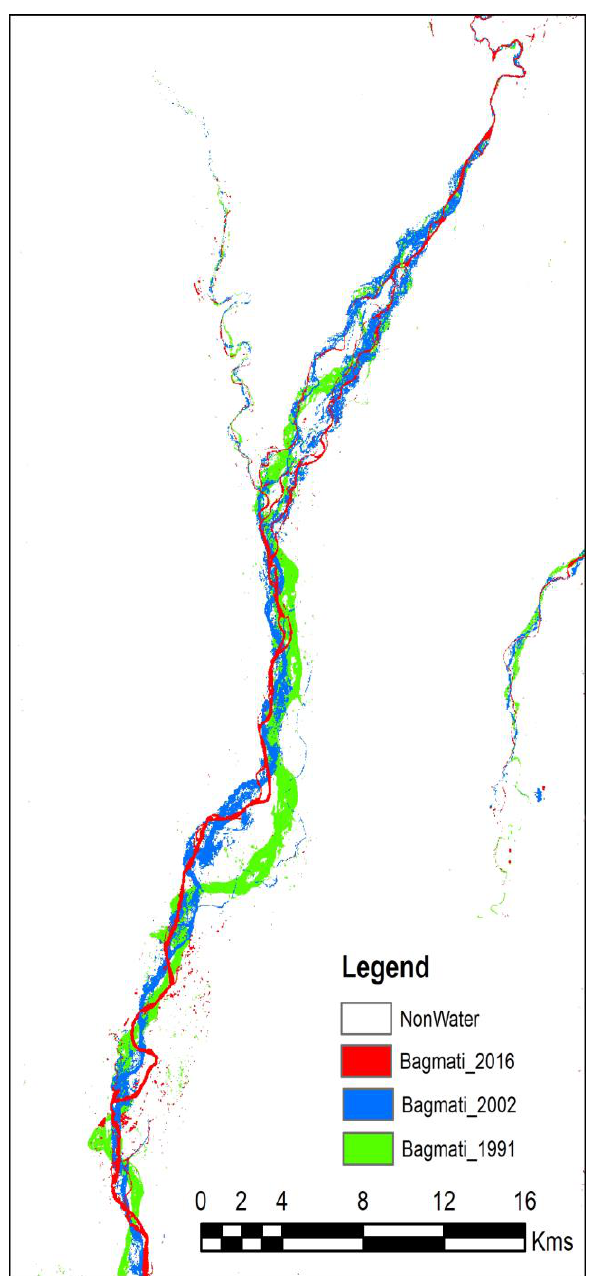
Figure 3. A map showing the changes during the 25-year period,